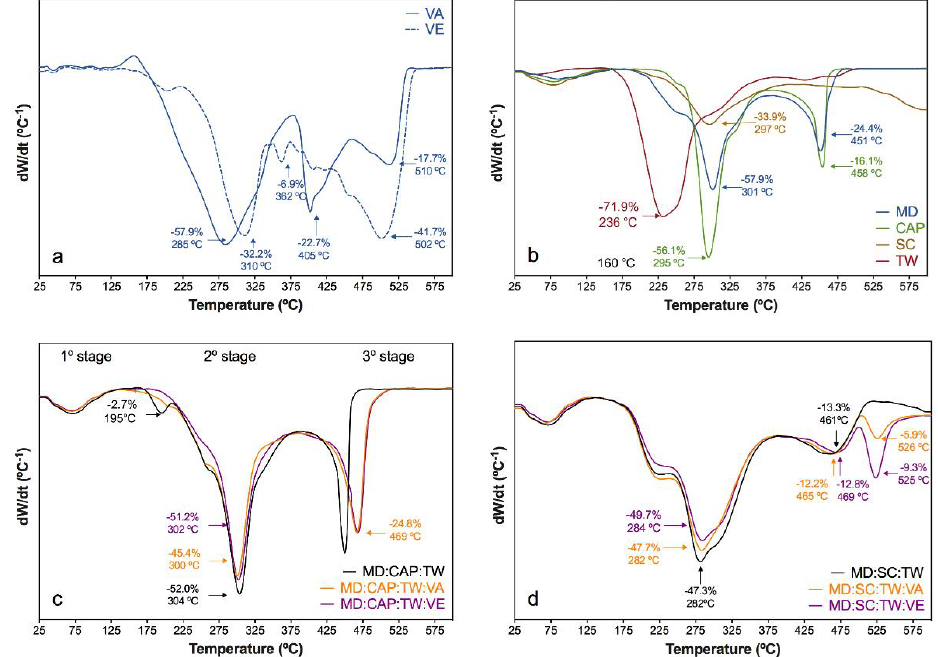
Figure 5. DTGA curves under oxidative atmosphere of ( a ) vitamin A (VA) and vitamin E (VE); ( b ) MD, CAP, SC, and TW components; and comparison of the vitamin encapsulation using ( c ) MD:CAP:TW and ( d ) MD:SC:TW